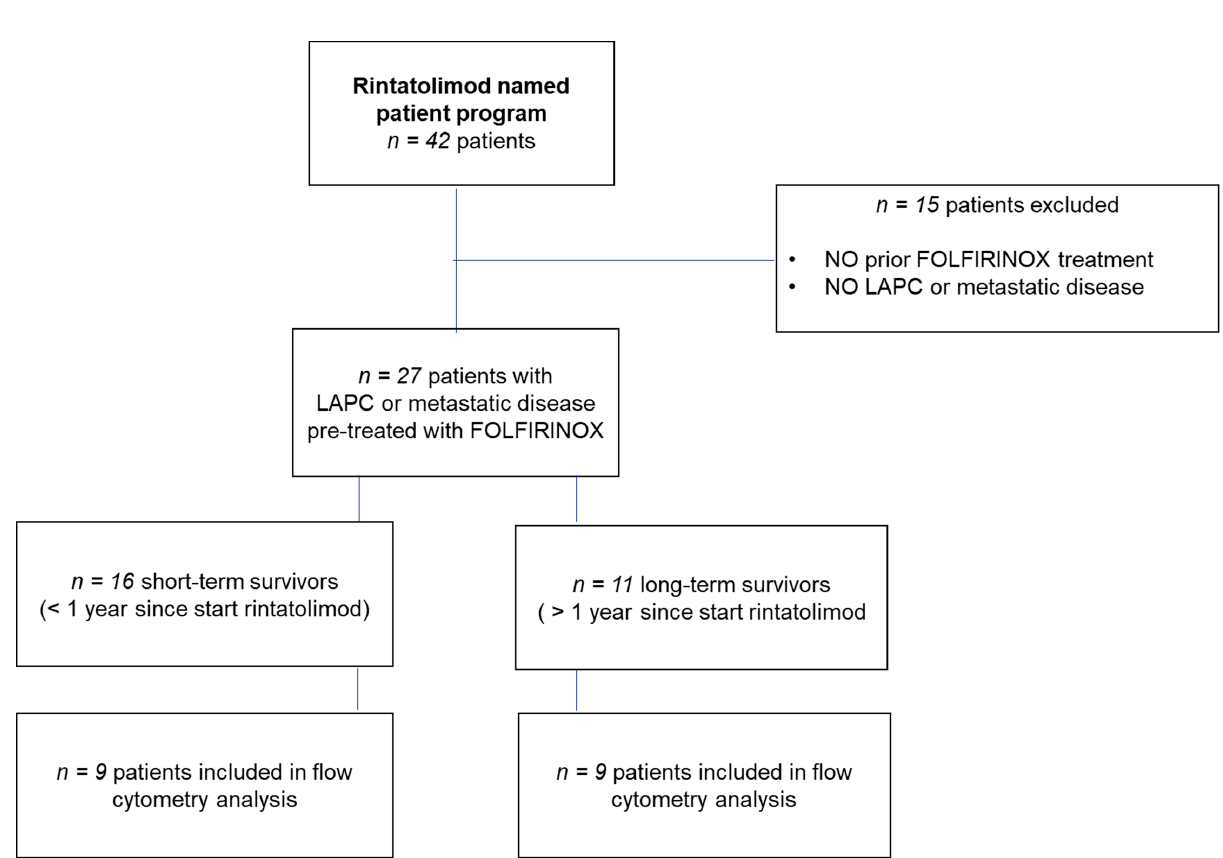
Figure 1. Profile of the single-center name patient program. Table 2. Patient characteristics.